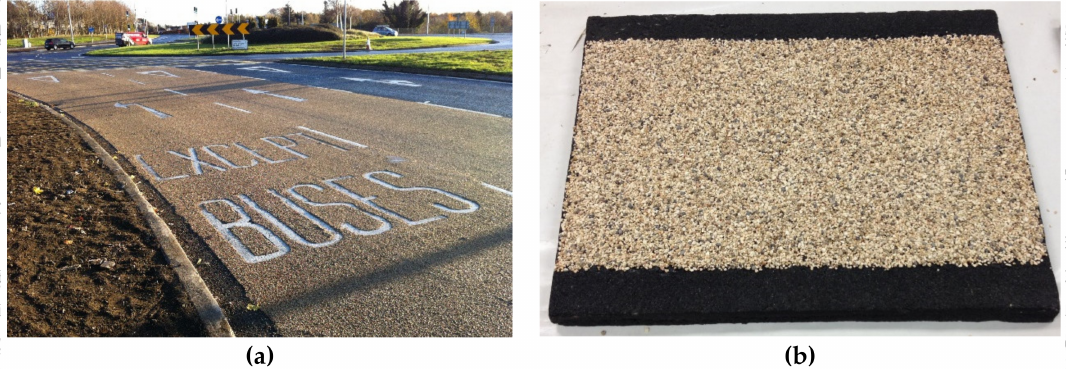
Figure 1. ( a ) Newly laid HFS system in Ireland; ( b ) cold applied HFS specimen used in Experiment